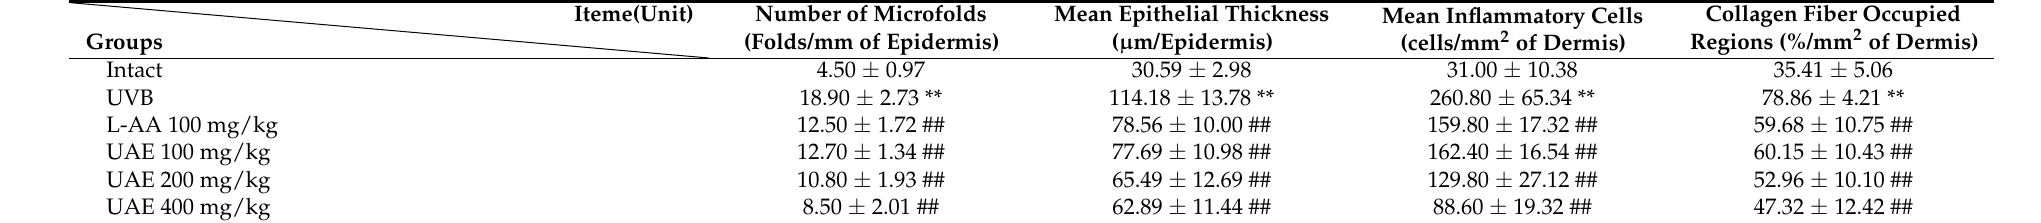
Table 1. Histopathological changes in UVB-irradiated dorsal back skin tissue.